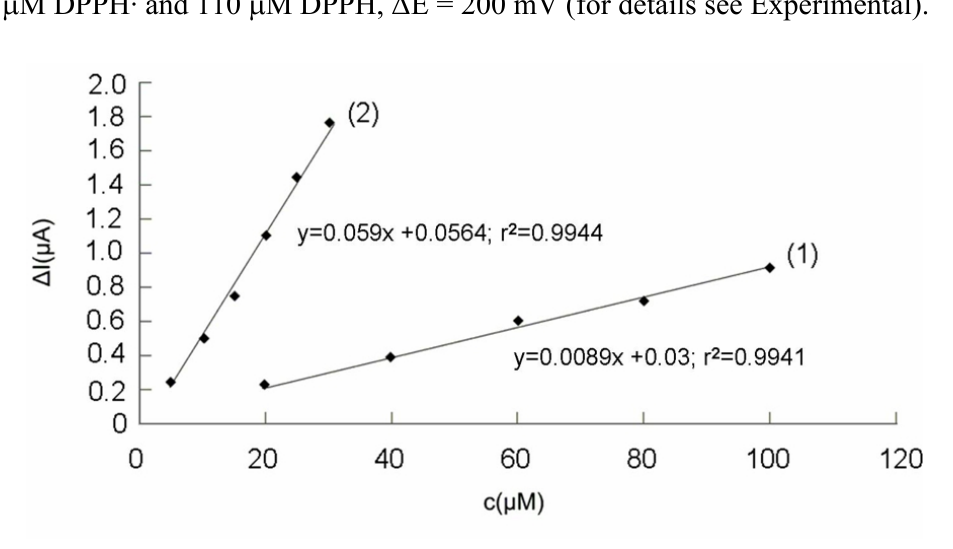
Figure 7 . Analytical response of the biamperometric detector plotted against DPPH· concentrations (1) for 110 μ M DPPH and Δ E = 200 mV and Trolox ® concentrations; (2) for 100 μ M DPPH· and 110 μ M DPPH, Δ E = 200 mV (for details see